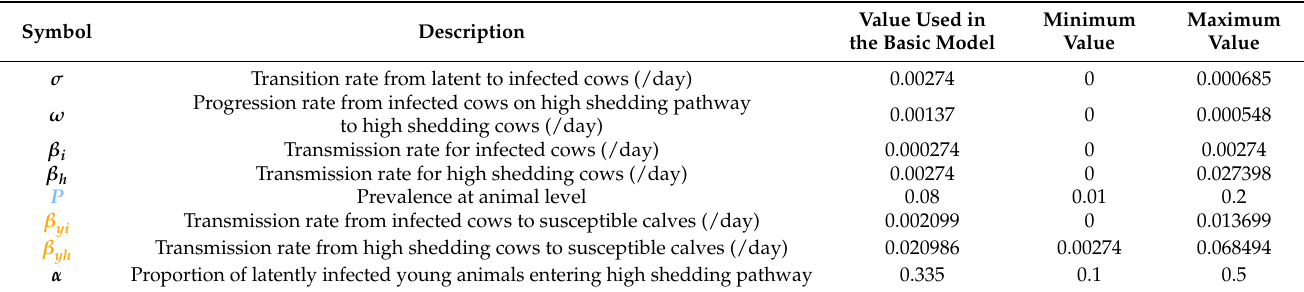
Table 3. Minimum and maximum values for the epidemiologically most important parameters used in the sensitivity